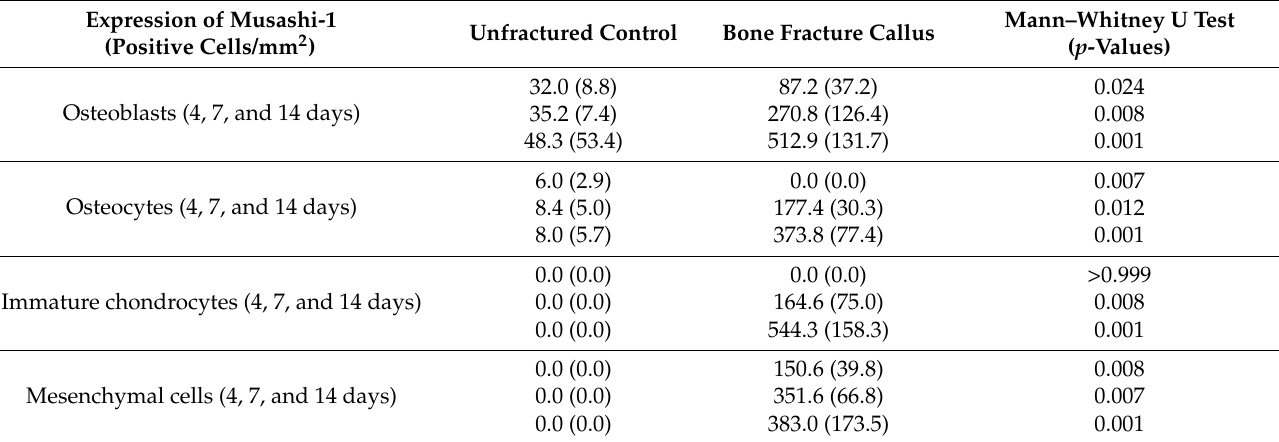
Mann–Whitney U Test